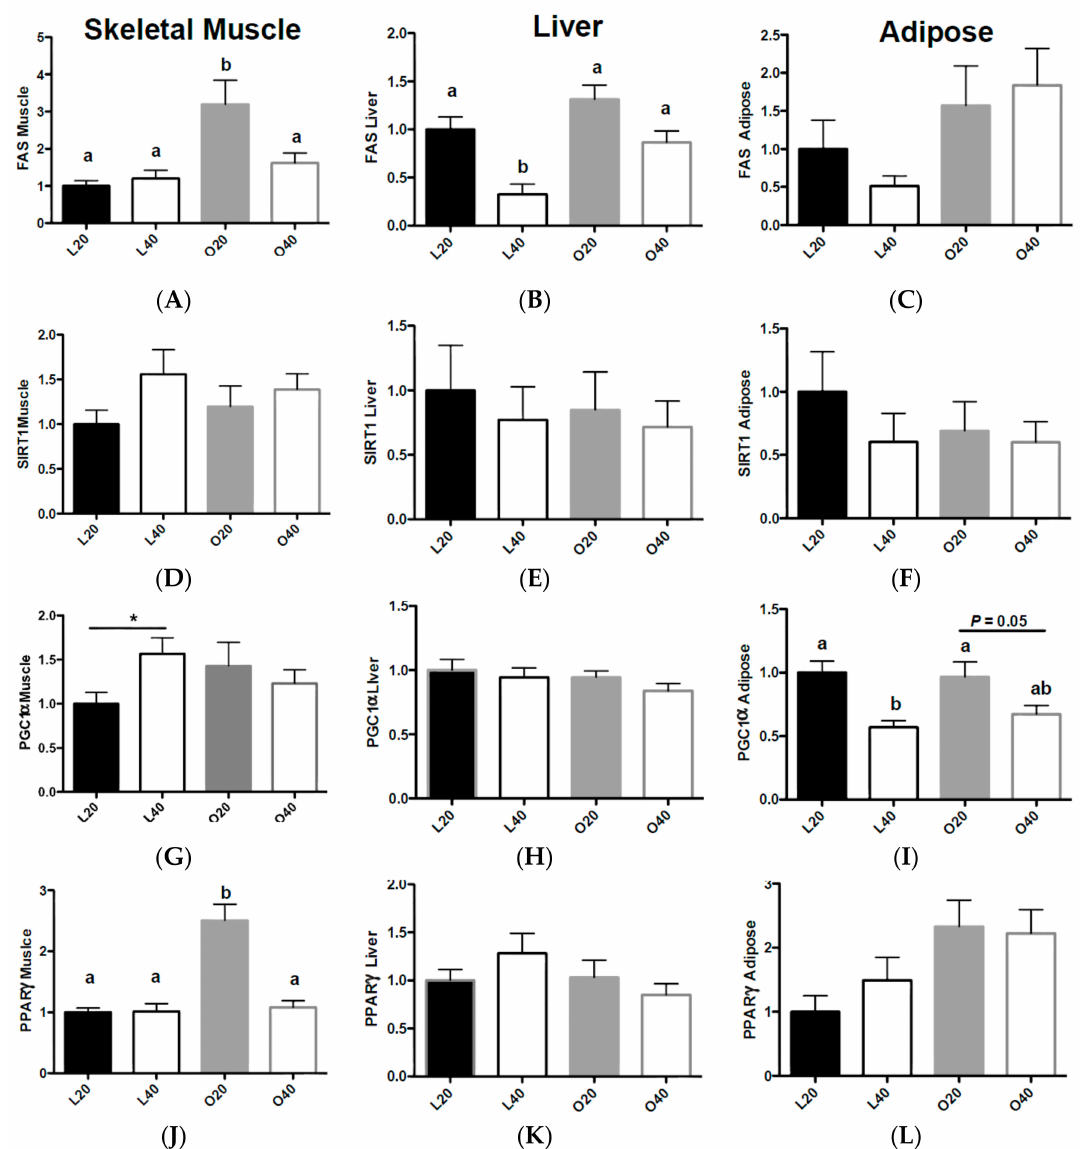
Figure 3. Effects of dietary protein concentration on gene expression in skeletal muscle, liver and epididymal adipose tissue following 12 weeks of consuming either a 20% protein or 40% protein diet in lean control (L) or obese Zucker (O) rats. Relative expressions of target genes were determined using the 2- ∆∆ Ct method. All genes are expressed relative to 18S, the control gene. ( A ) Fatty acid synthase (FAS)expression in skeletal muscle; ( B ) FAS expression in liver; ( C ) FAS expression in adipose tissue; ( D ) Sirtuin 1 (SIRT1) expression in skeletal muscle; ( E ) SIRT1 expression in liver; ( F ) SIRT1 expression in adipose tissue; ( G ) Peroxisome proliferator-activated receptor- γ coactivator-1 α (PGC1 α ) expression in skeletal muscle; ( H ) PGC1 α expression in liver; ( I ) PGC1 α expression in adipose tissue; ( J ) Peroxisome proliferator-activated receptor- γ (PPAR γ ) expression in skeletal muscle; ( K ) PPAR γ expression in liver; ( L ) PPAR γ expression in adipose tissue. Values are means + SEM. Data was analyzed using one-way ANOVA. Values without a common letter differ, p < 0.05. Values with an * were analyzed via t -test and are significantly different within a group (20% versus 40% protein), p < 0.05. L20, lean 20% protein; L40, lean 40% protein; O20, obese 20% protein; O40, obese 40%